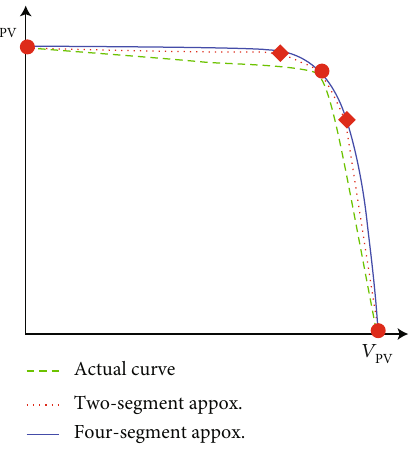
Figure 4: Piecewise linearization of I-V curve.